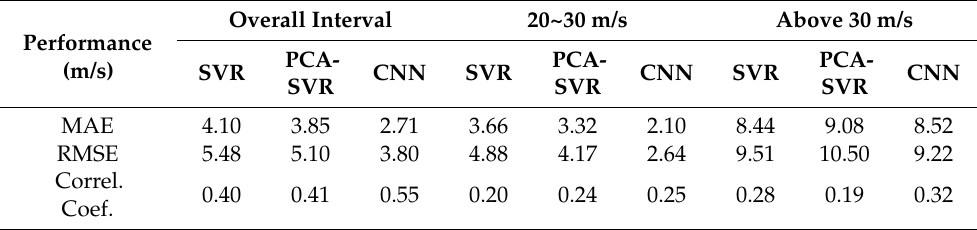
Figure 6. ( a ) SVR model wind speed inversion results; ( b ) PCA-SVR model wind speed inversion results; and ( c ) CNN model wind speed inversion results. The color bar on the right represents data density. Table 2. Model performance analysis (Correl. Coef. represents the correlation